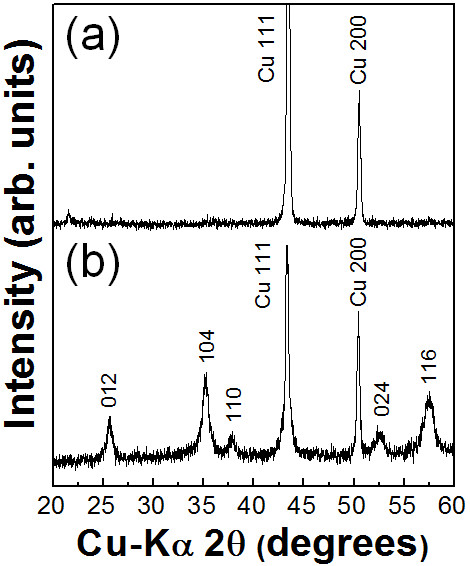
XRD patterns of the (a) Al2O3-PMMA (30 vol.%) composite films and (b) Al2O3films.